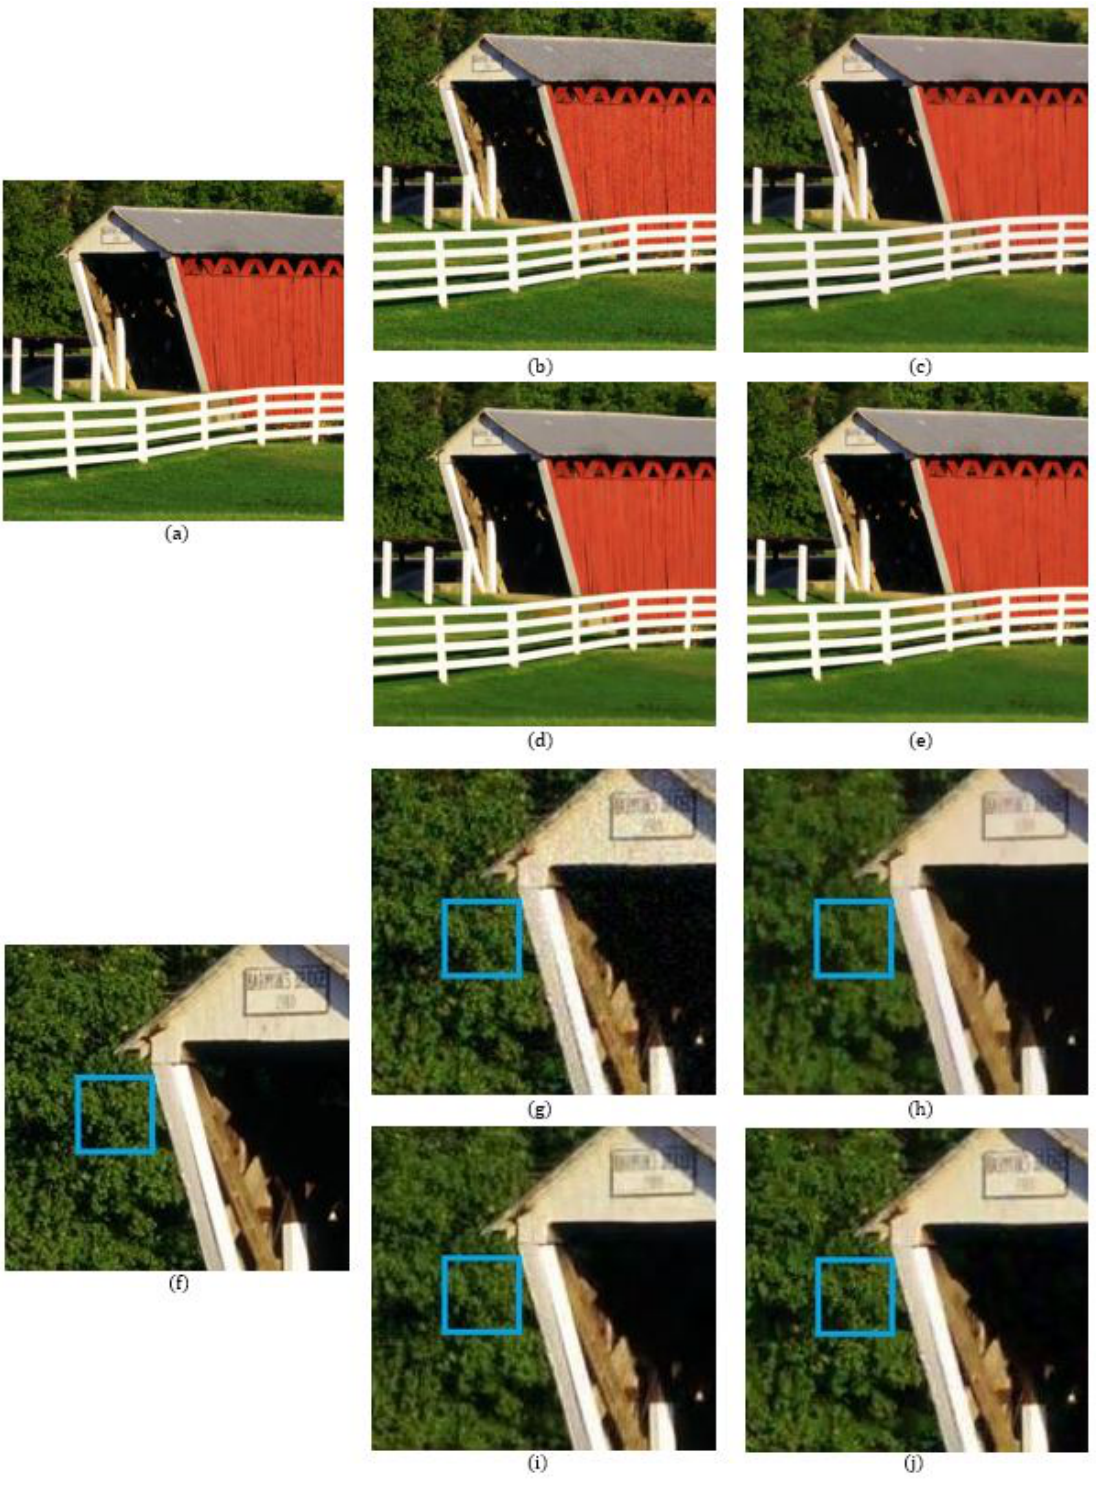
Figure 7. Comparison of the results between the different methods on MCM image 18: ( a , f ) Original; ( b , g ) RI [4] (psnr = 27.7879 dB); ( c , h ) ADMM [9] (psnr = 28.2356 dB); ( d , i ) BM3D [7] (psnr = 29.2443 dB); ( e , j ) proposed (psnr = 28.6549